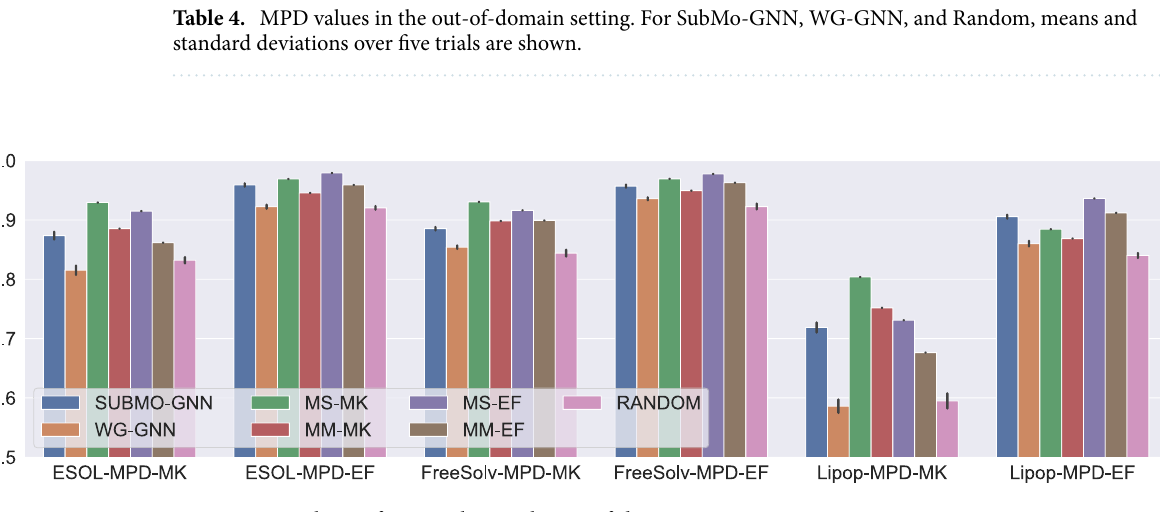
Figure 7. Bar charts of MPD values in the out-of-domain